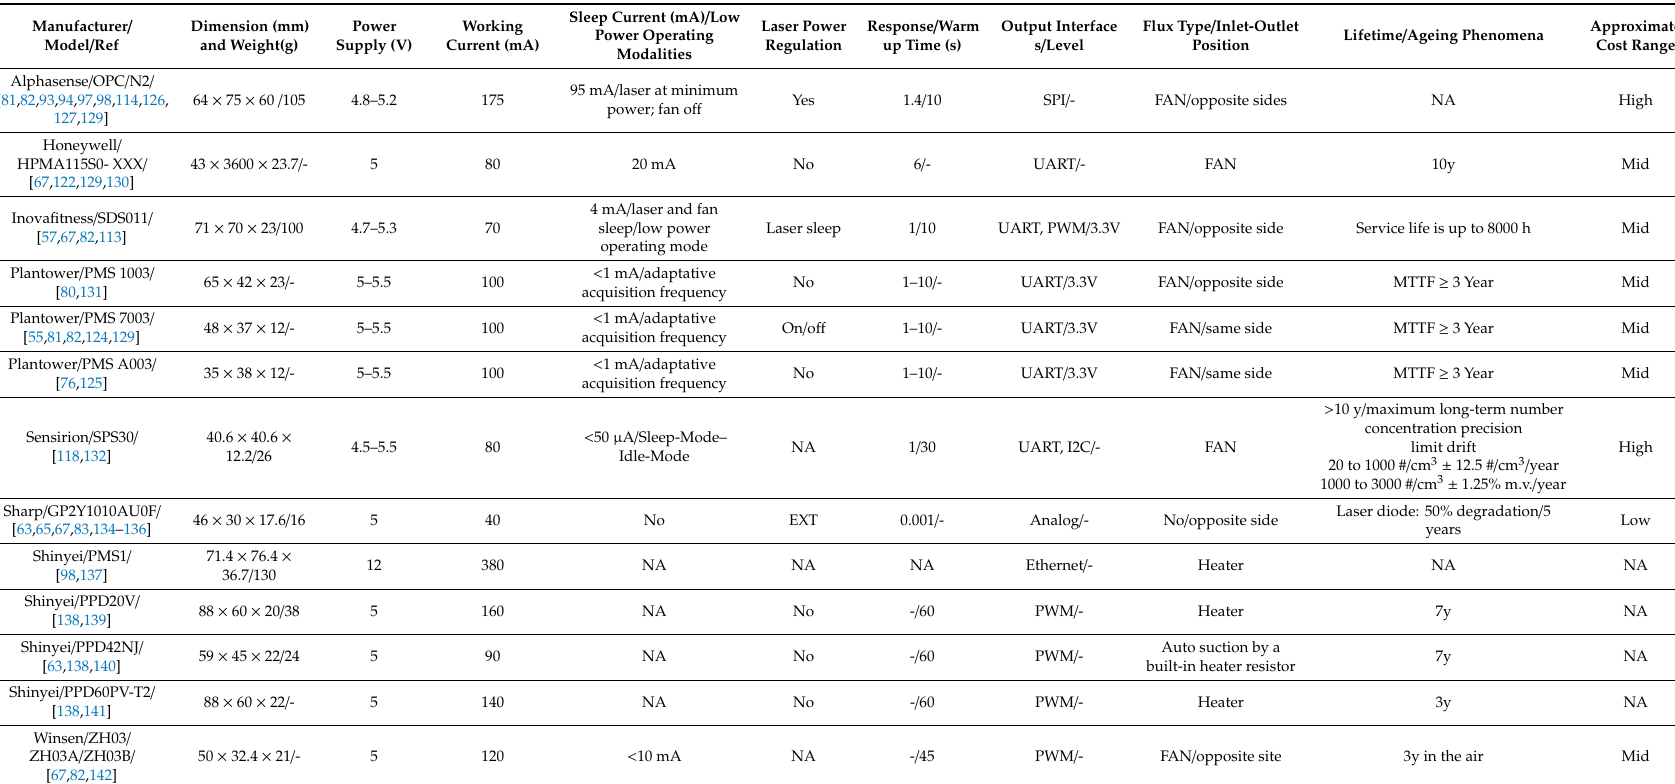
Table 6. Technical characteristics. The first column reports, together with the manufacturer’s name, the device model, and the numbers related to the papers that discuss applications based on that sensor model. Column 2 refers to the LCPMS dimension and weight. Column 3 is related to the power supply required by the device and indicates the power input required to properly supply the sensor. In column 4, the maximum absorption of current during normal device operations is reported. In column 5, the current in mA consumed by the sensor when in sleep mode (if applicable) is shown. Column 6 reports the ability to regulate the power of the laser source, providing a chance for the designer to regulate the power consumption of the entire system. Column 7 reports the “Response / warm up time” for the various devices listed. This parameter indicates the minimum time required by the sensor to give a response after a query. Column 8 reports information related to the “Output interface (Bus type) / Level”. Column 9 reports the “Flow type / inlet-outlet position” parameter, which indicates how sampled air is able to enter into the detection chamber. Column 10, “Lifetime / ageing phenomena”, reports data related to the device’s lifetime reliability to provide information related to system maintenance. The last column, “Approximate Cost range”, shows the price range (synthetic parameter) at the time of this review (approximately low ≤ 15 EUR; 15 EUR < mid < 60 EUR; high ≥ 60 EUR) to outline, along with the other parameters, the quality / price ratio of each